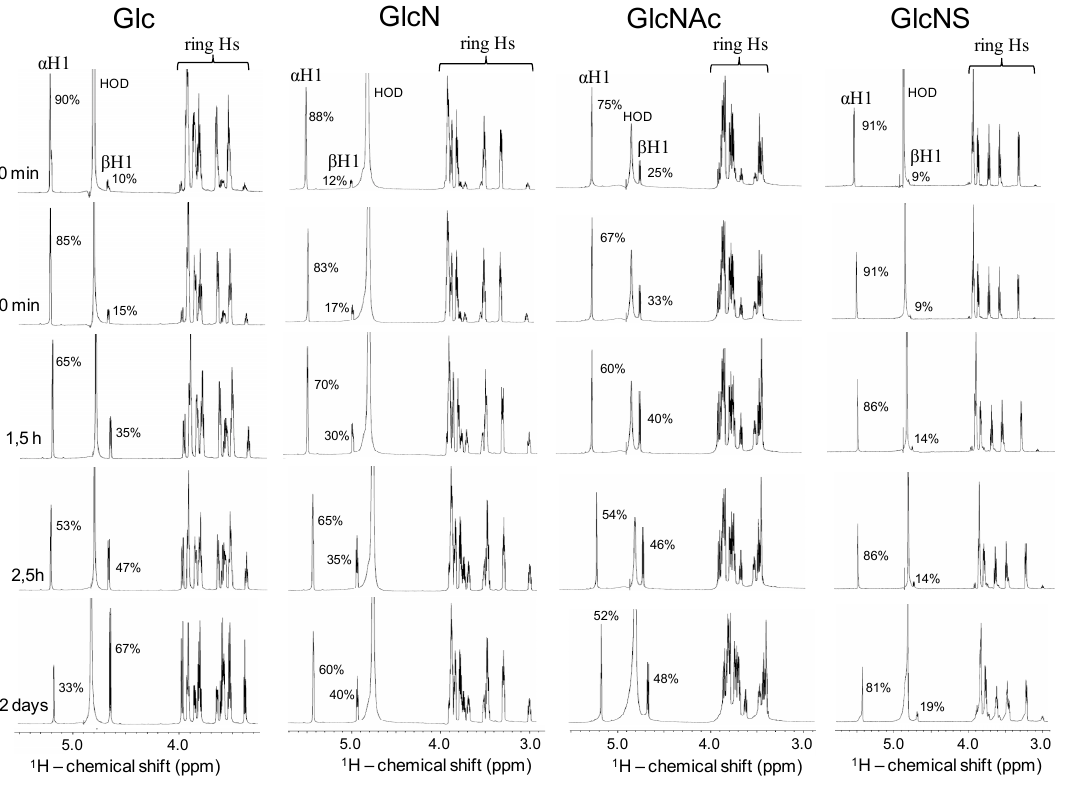
Figure 4. Kinetics of anomeric mutarotation observed for glucose (Glc) and Glc-based standards such as glucosamine (GlcN), N -acetyl glucosamine (GlcNAc) and N -sulfo-glucosamine (GlcNS) measured through 1D 1 H NMR spectra recorded within different time courses after dissolution in 100% D 2 O (10 mg/mL). Anomeric proton signals ( α H1 and β H1), their respective relative percentages and ring proton signals are indicated in the panels. HOD denotes residual water signals. Spectra were recorded at 18.8 T and 25 °C.